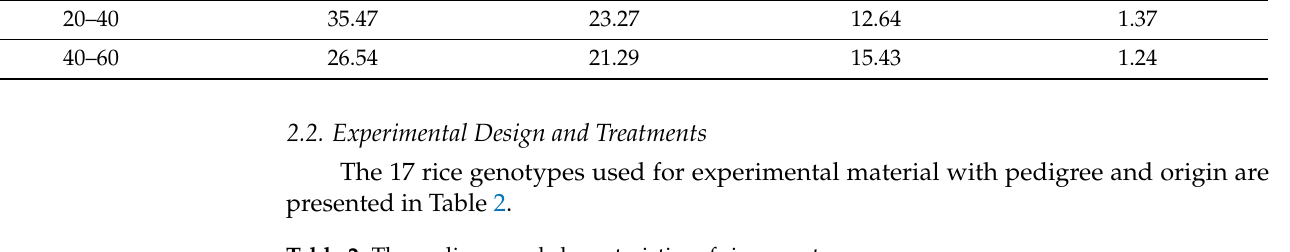
Table 2. The pedigree and characteristics of rice